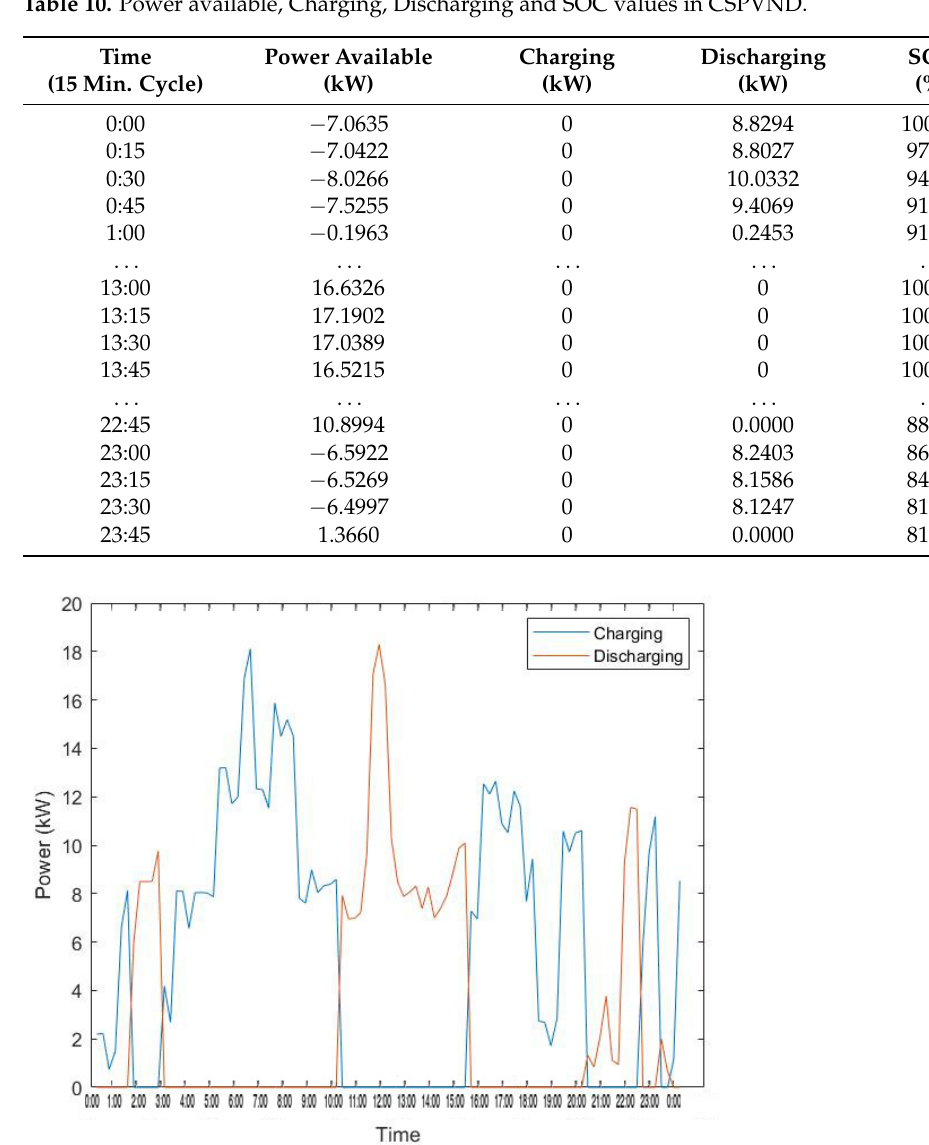
Figure 21. State of charge of Street Battery in CSPVND.